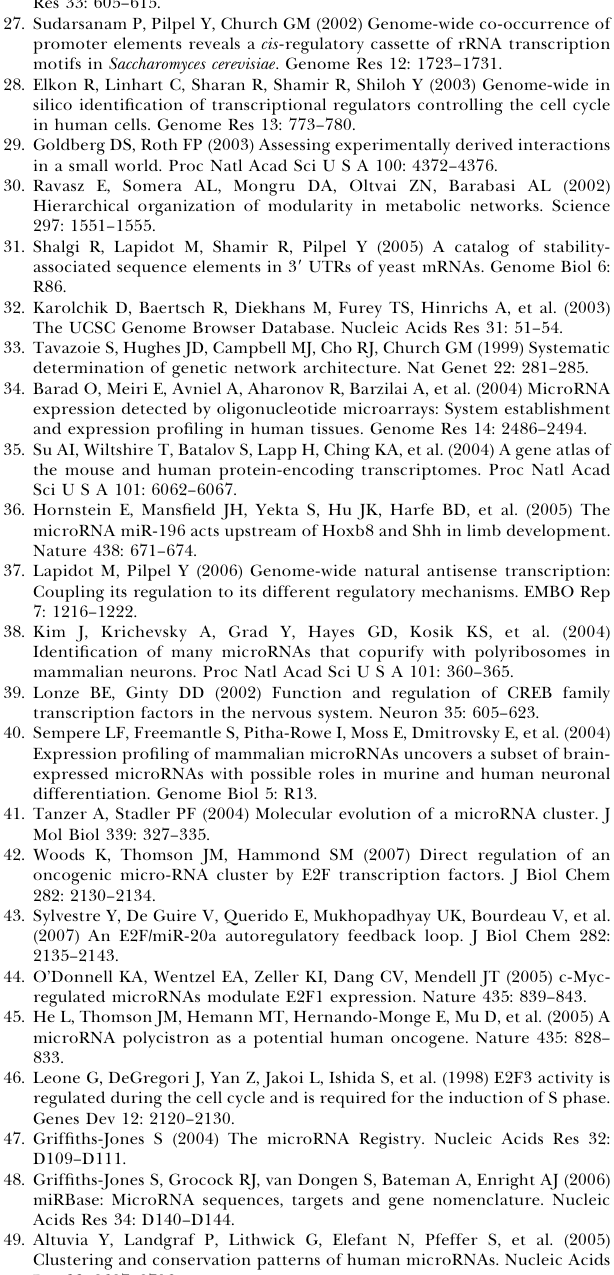
Table S5. Significant Co-Occurring miR–TF Pairs in the PicTar Network, Taking 5 kb Regulatory Regions for Protein Coding Genes Found at doi:10.1371/journal.pcbi.0030131.st005 (103 KB XLS). Table S6. Indirect FFLs in the TargetScan Dataset Table S7. Indirect FFLs in the PicTar Dataset Taking 10 kb Regulatory Regions for Protein Coding Genes Found at doi:10.1371/journal.pcbi.0030131.st007 (47 KB XLS). Table S8. Indirect FFLs in the PicTar Dataset Taking 5 kb Regulatory Regions for Protein Coding Genes Found at doi:10.1371/journal.pcbi.0030131.st008 (29 KB